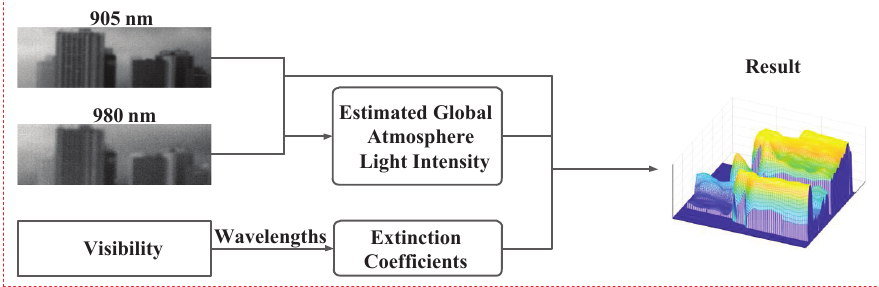
Figure 1. Main components of the proposed bispectral distance sensing